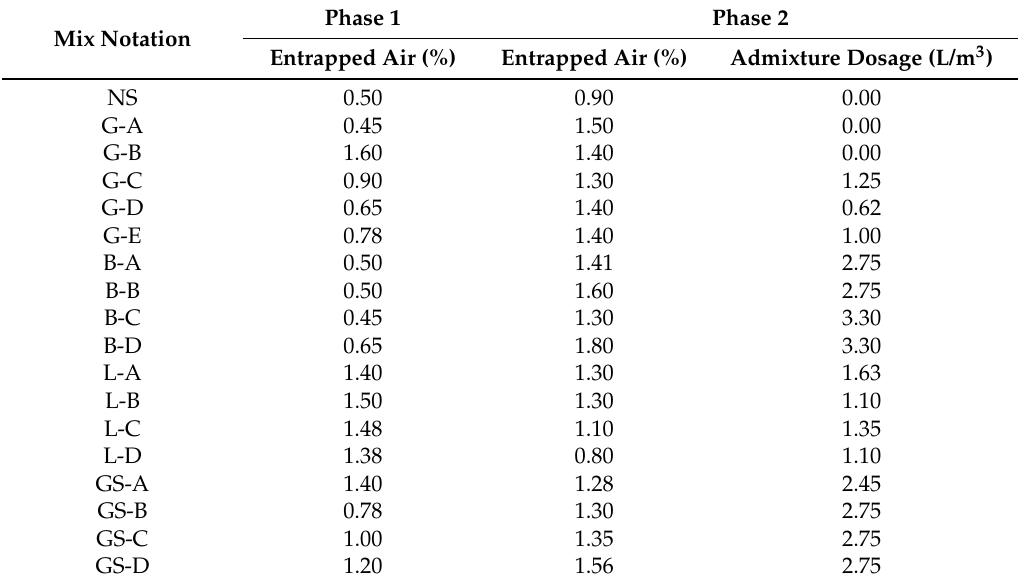
Table 5. Entrapped air and admixture dosage for Phase 1 and Phase 2